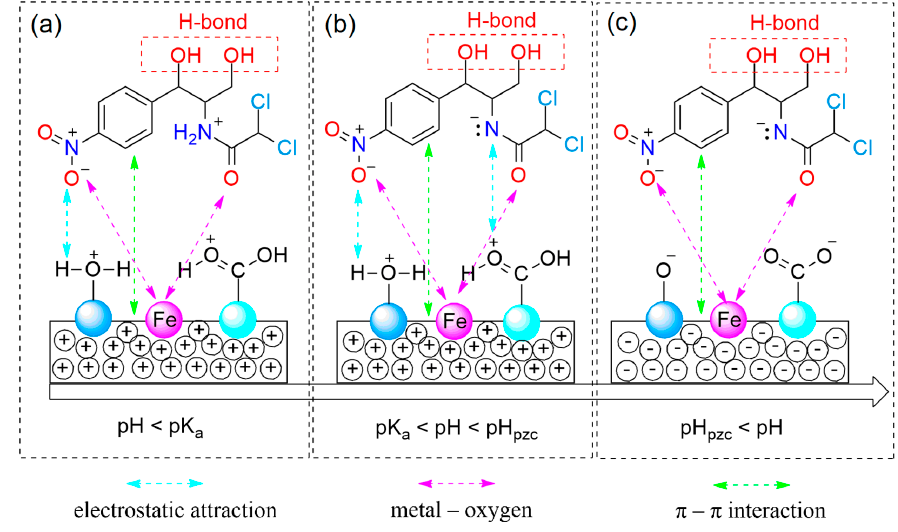
Figure 8. Proposed mechanism: ( a ) pH < pK a ; ( b ) pK a < pH < pH pzc ; and ( c ) pH pzc < pH.